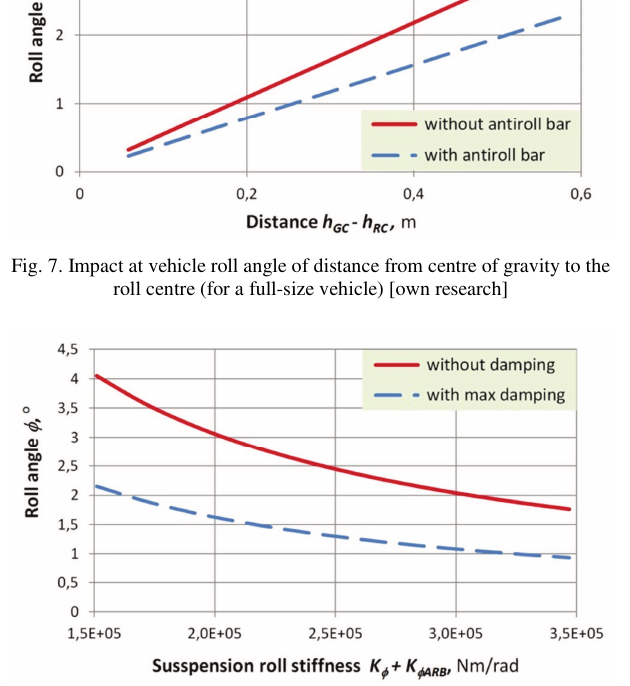
Fig. 8. The impact at vehicle roll angle of the roll stiffness of suspension (for a full-size vehicle) [own